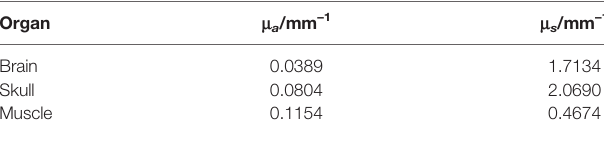
TABLE 1 | Optical parameters of main organs.